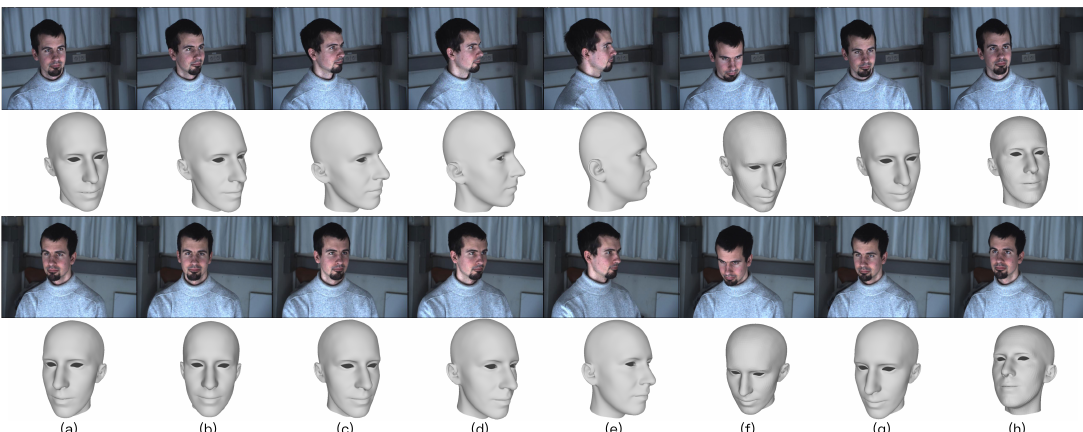
Figure 9. Reconstruction results under varying pose. Each column, from ( a – h ), is images captured simultaneously from two viewpoints (row 1 and 3) and their reconstruction meshes (row 2 and 4) from pose0 to pose7 using the proposed method.